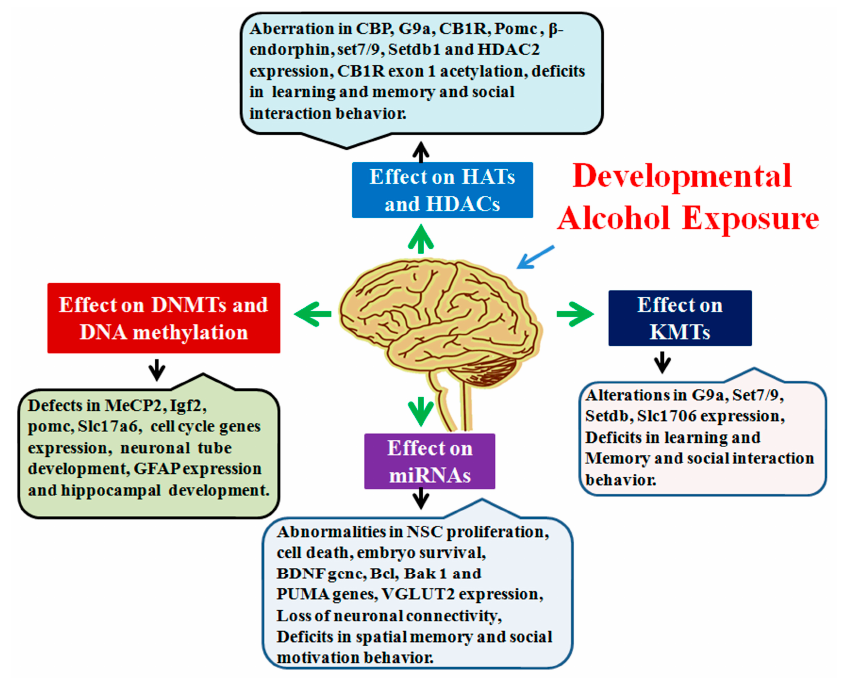
Figure 5. Graphical summary of developmental alcohol-induced epigenetic defects. Developmental alcohol exposure has been shown to affect DNA methylation, HATs/HDACs, KMTs and miRNAs, followed by several changes in genes and protein expression that are important for cognitive and other brain function.